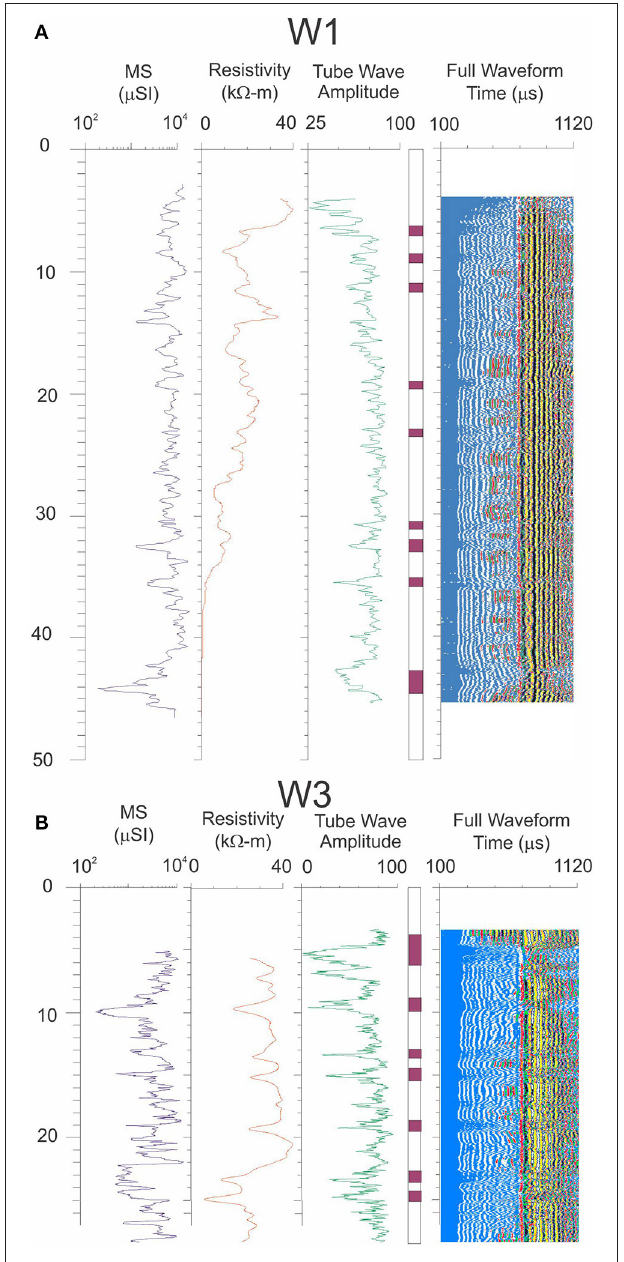
FIGURE 5 | Magnetic susceptibility (MS), capacitive resistivity, tube wave amplitude and full waveform log presented as a variable density log for (A) bedrock well W1 and (B) bedrock well W2. The purple horizontal bars in the second last column represent interpreted fractures/fracture zones. Note